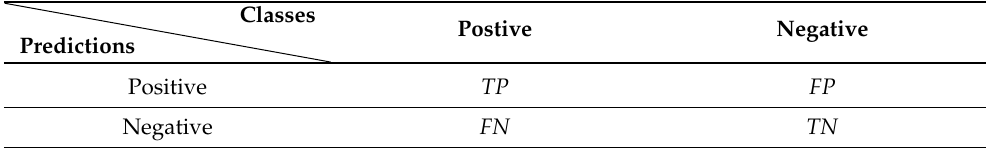
Table 3. Confusion matrix of a binary classification problem.